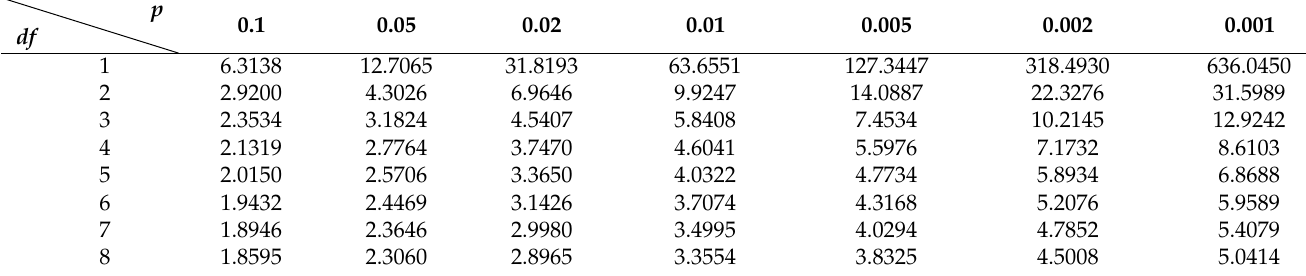
Table 1. p -value corresponding to the t